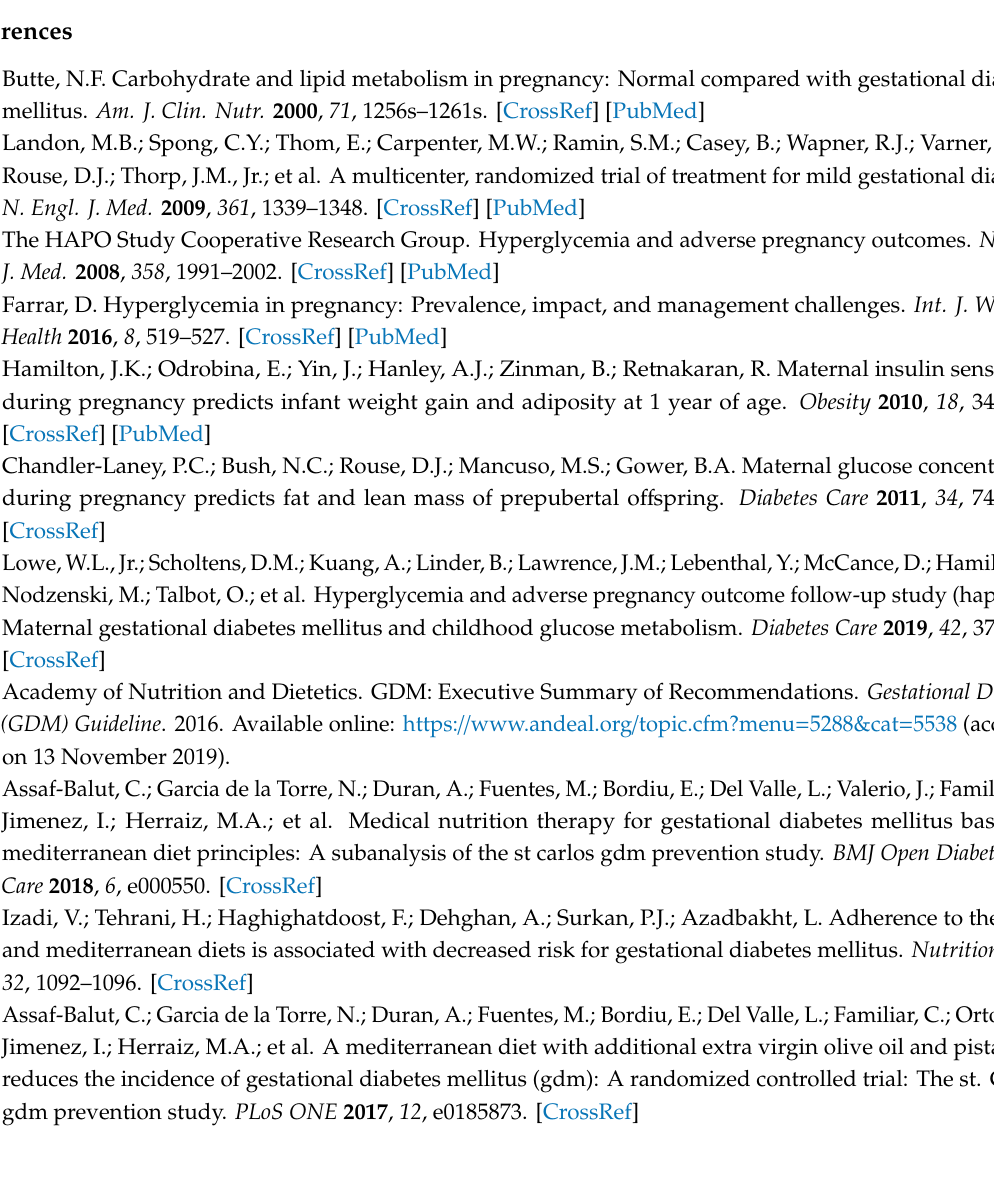
Table S1: Description of food groups and computation of the MDS, Table S2: Dietary intakes and population compliance to individual MDS components by stage of